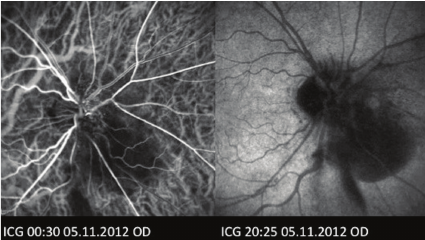
Figure 3: Indocyanine green angiography (ICGA) of the right eye showing absence of hyperfluorescent polyps to suggest the presence of polypoidal choroidal vasculopathy